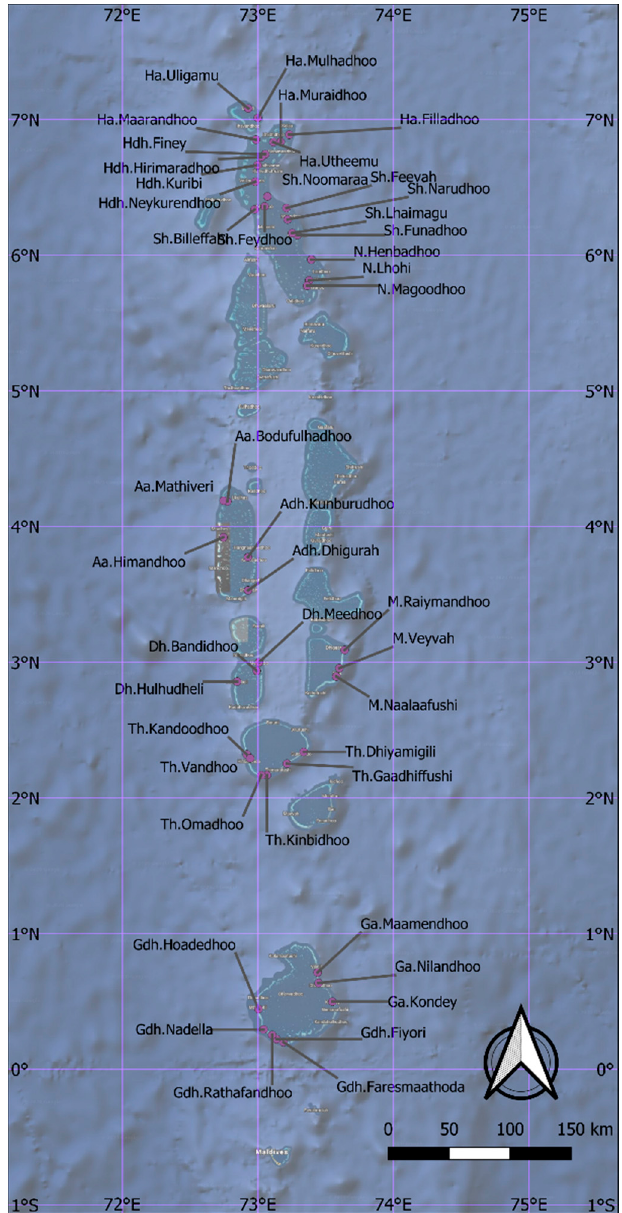
Figure 2. The 45 islands of the project “Supporting vulnerable communities in the Maldives to manage climate change-induced water shortages” (GCF project) were included in the study. There is a good distribution of islands over the Maldives. (Background Google Hybrid © map layer. Map created with QGIS 3.12 “Bucure ș ti”).